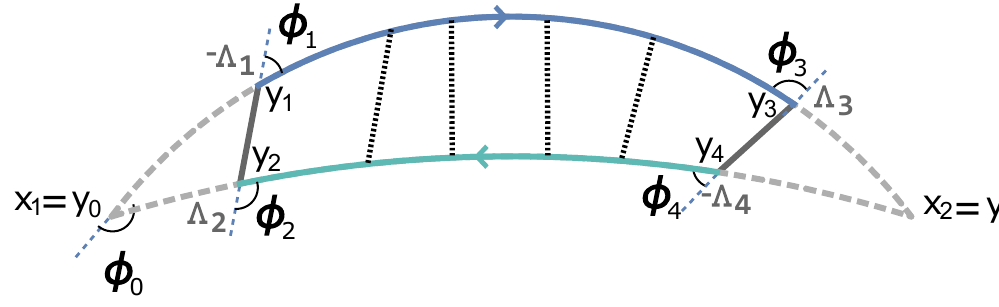
Figure 19 . The 4-cusp correlator. Its OPE-like expansion (9.1) provides predictions for the HLL structure